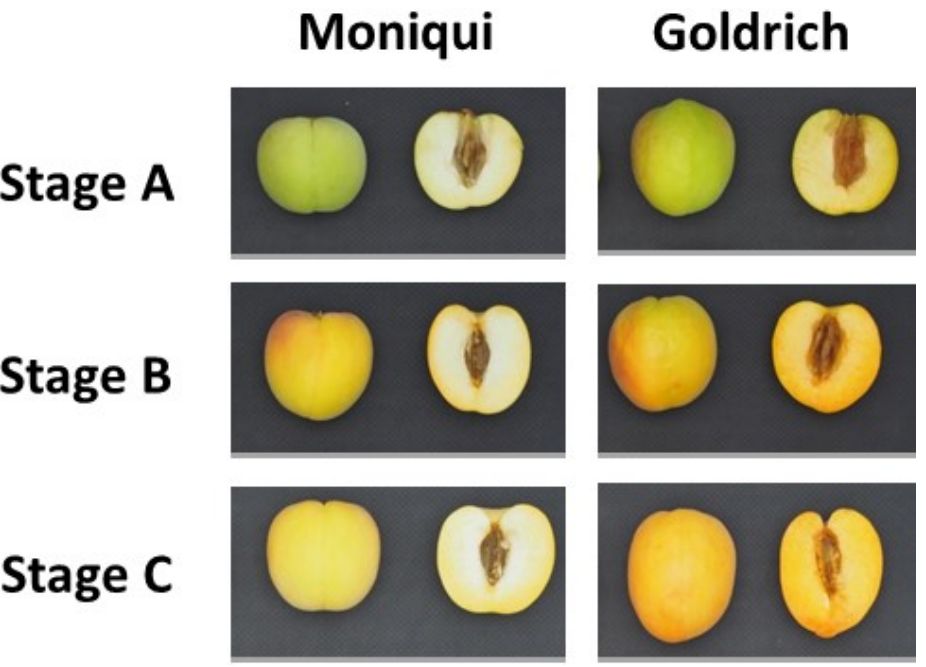
Figure 13. Ripening stages before stone hardening based on their skin ground color and firmness assayed in this study in the light yellow cultivar ’Moniquí’ and the orange cultivar ‘Goldrich’: green fruit ( Stage A ), during color change ( Stage B ) and at physiological ripening ( Stage C ).